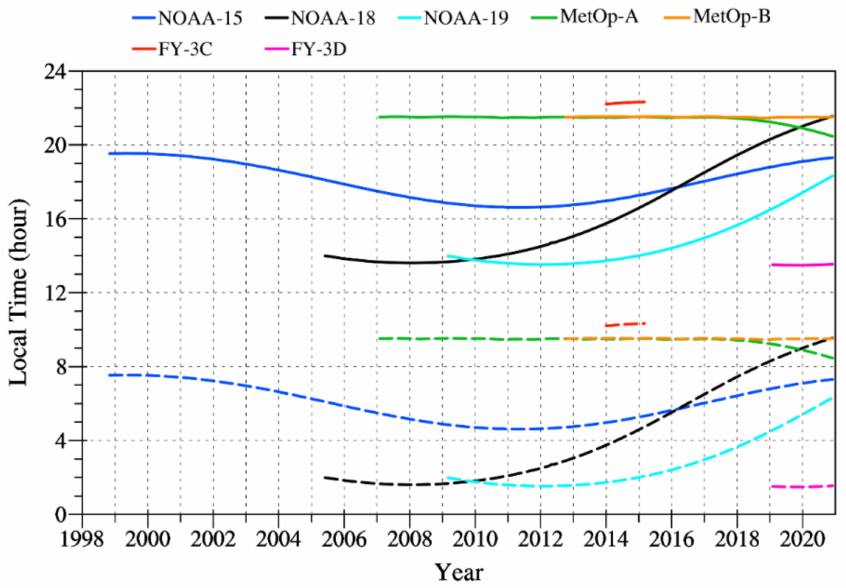
Figure 1. Monthly mean local equator-crossing times of the polar-orbiting meteorological satellites NOAA-15/18/19, MetOp-A/B, and FY-3C/3D calculated from near-nadir observations on ascending (solid curves) and descending (dashed curves) nodes from October 1998 to December